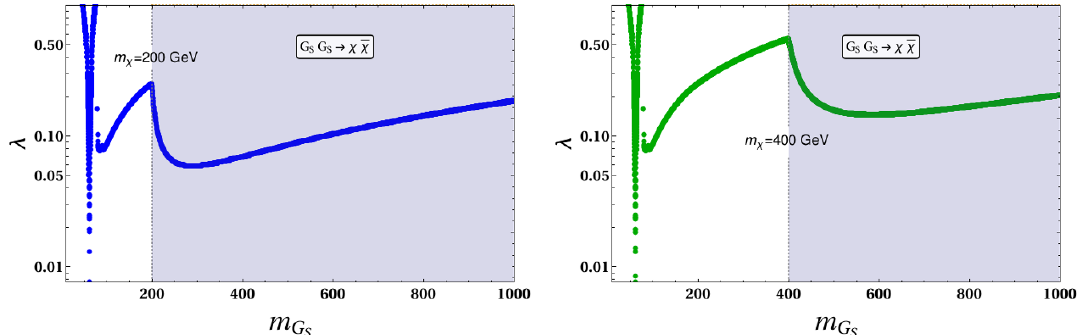
Figure 12 . Relic density as a function of m G (green) and 0 : 5 (cid:0) 2 (purple). We assumed all 15 pNBGs are degenerate and included the e(cid:11)ects of the pNBG-LSP interaction with tan (cid:12) = 5, C = 0 : 2, and a neutralino mass of m (cid:31) (left) or m (cid:31) = 400 GeV (right). 0